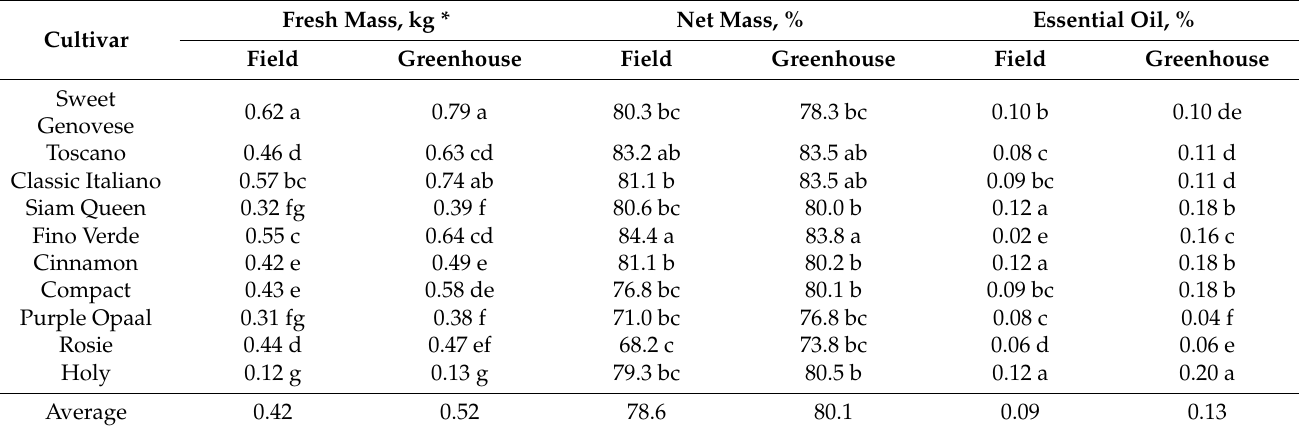
Table 3. Productivity and amount of essential oil of basils grown in field and greenhouse.